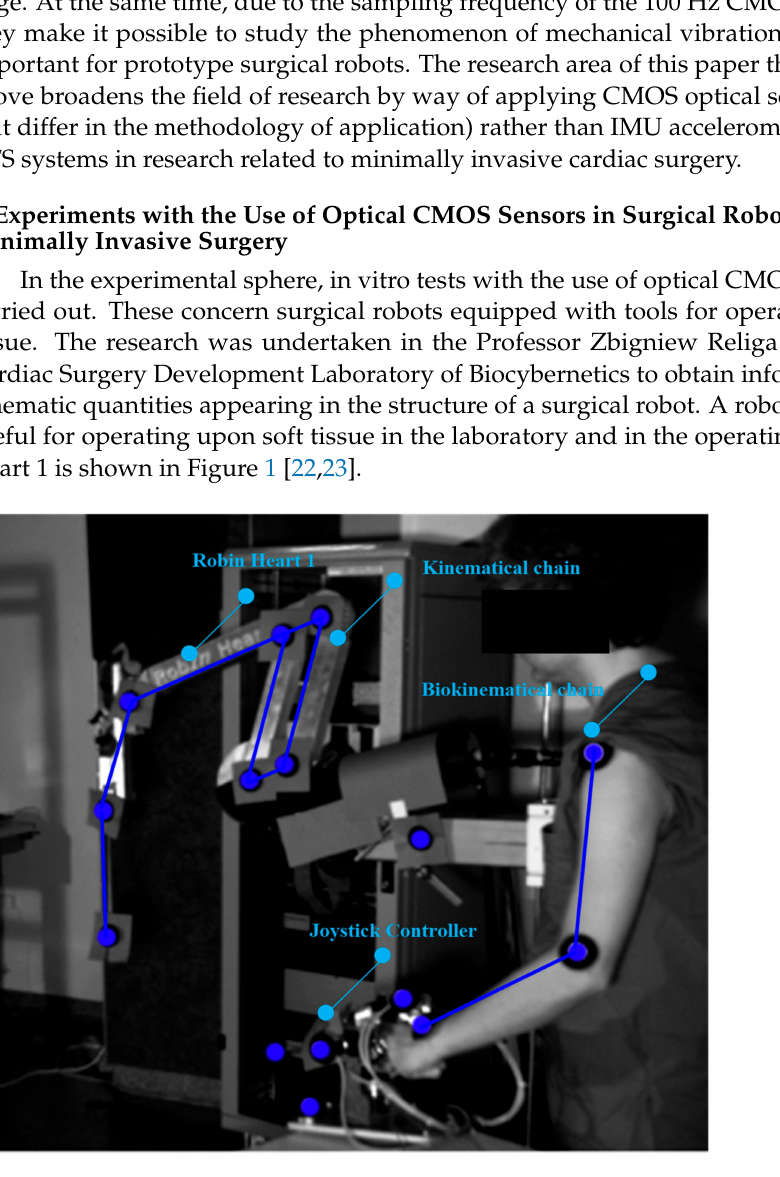
Figure 1. Robin Heart 1 surgical robot for soft tissue surgery, endoscopic controller and robot operator with reflective markers attached to the biokinematical